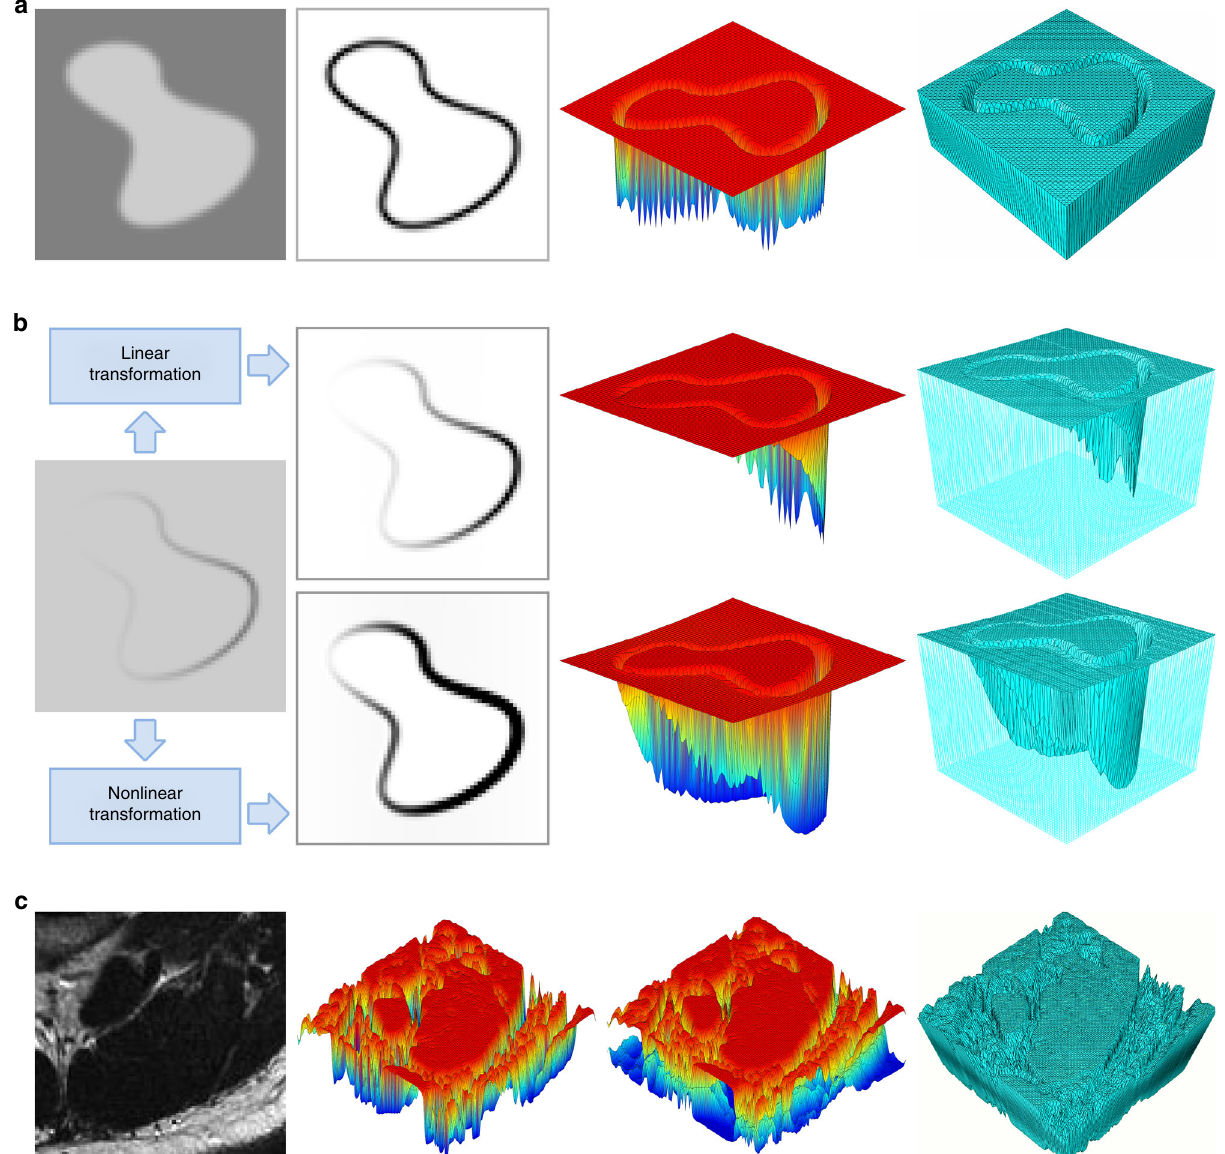
Fig. 1 Establish mechanical models from images. a From left to right: original image, gradient image, grayscale trend of the gradient image, and mechanical model established from the gradient image. b From left to right: original image, images after intensity transformation, grayscale trend of the images in the second column, and perspective mechanical models corresponding to those same images. c From left to right: magnetic resonance image of head and neck muscles, grayscale trend of the one-sided model, grayscale trend of the two-sided model, and bilateral symmetric mechanical